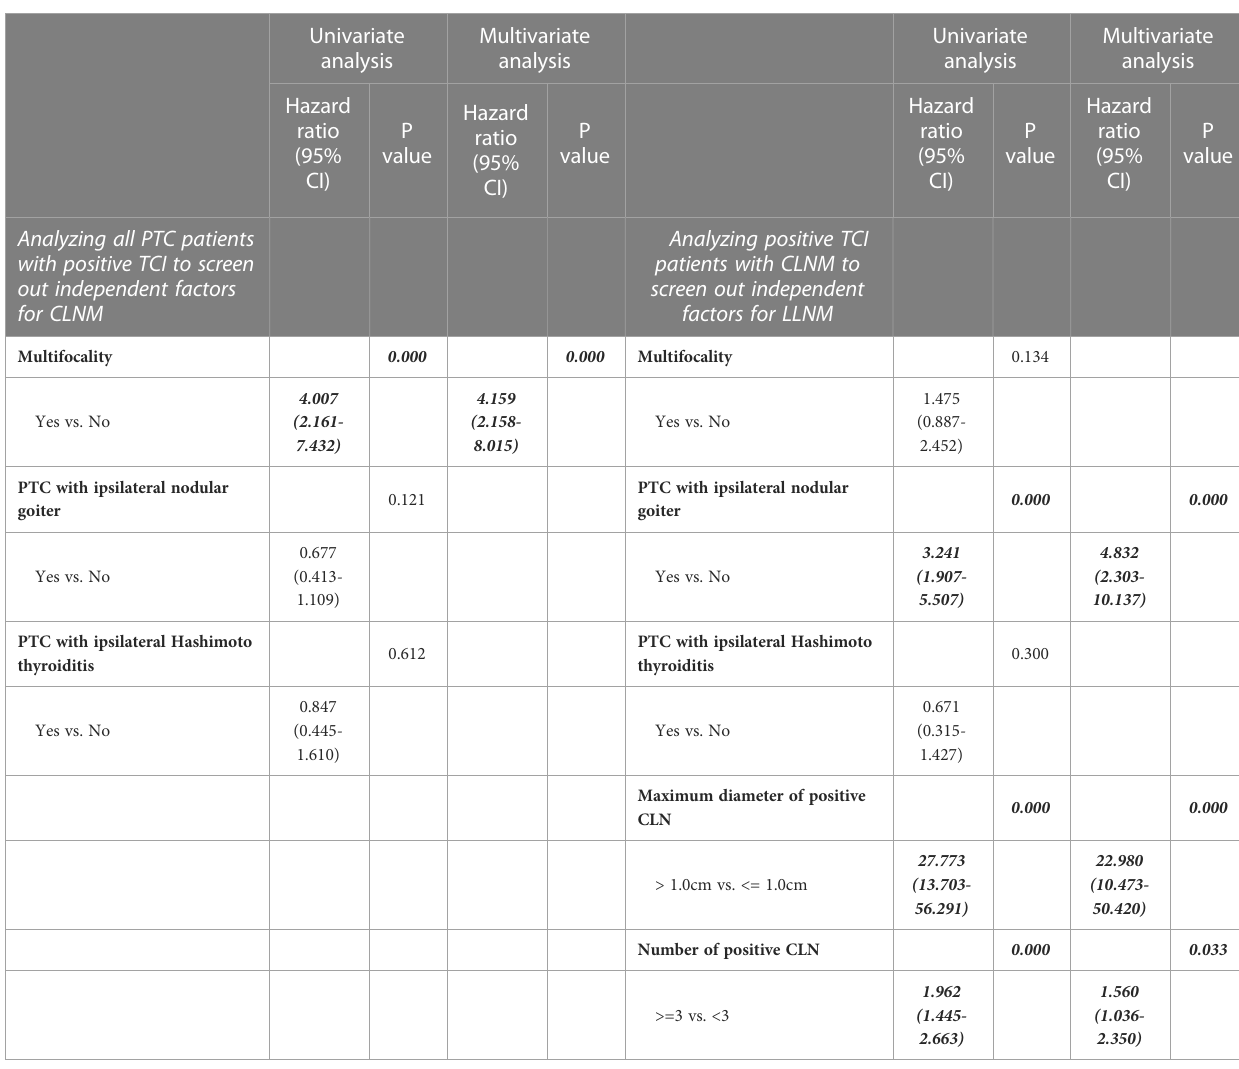
agreement between the actual and estimated possibility of LLNM in patients with positive CLNM in the no-TCI